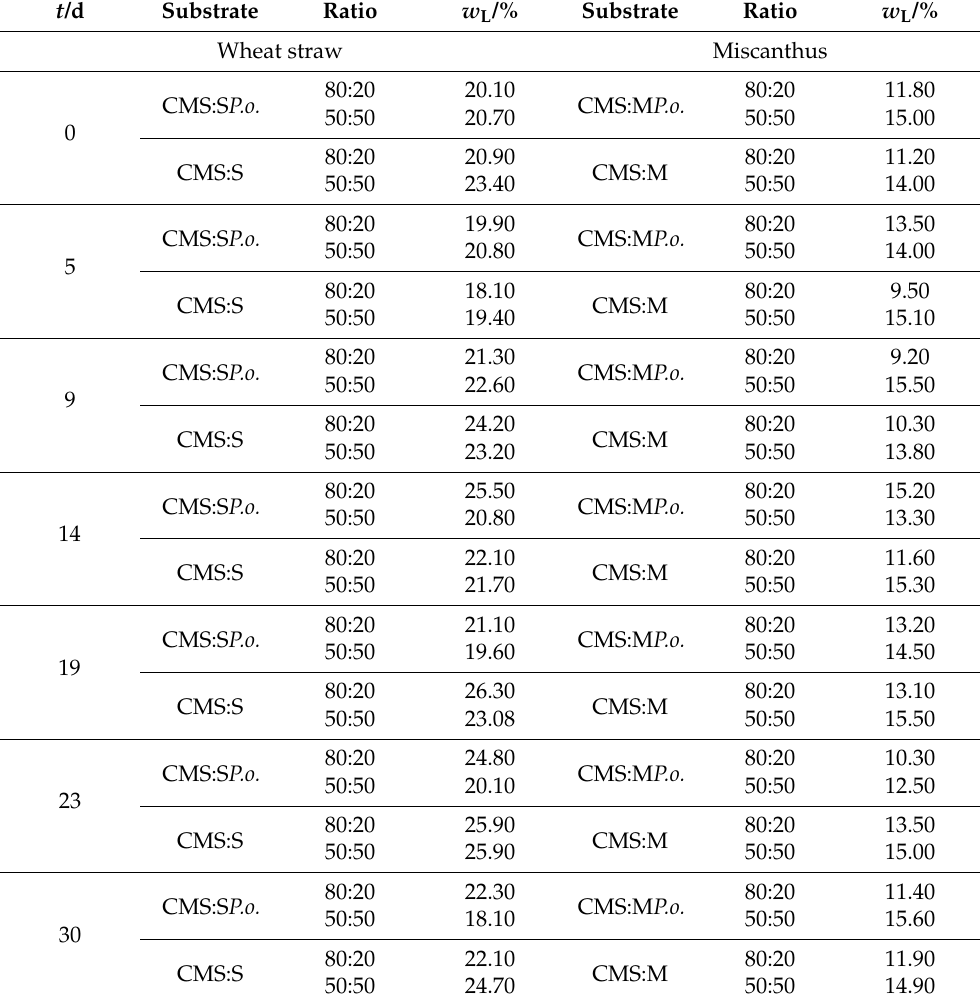
Table 1. Concentrations of acid-insoluble